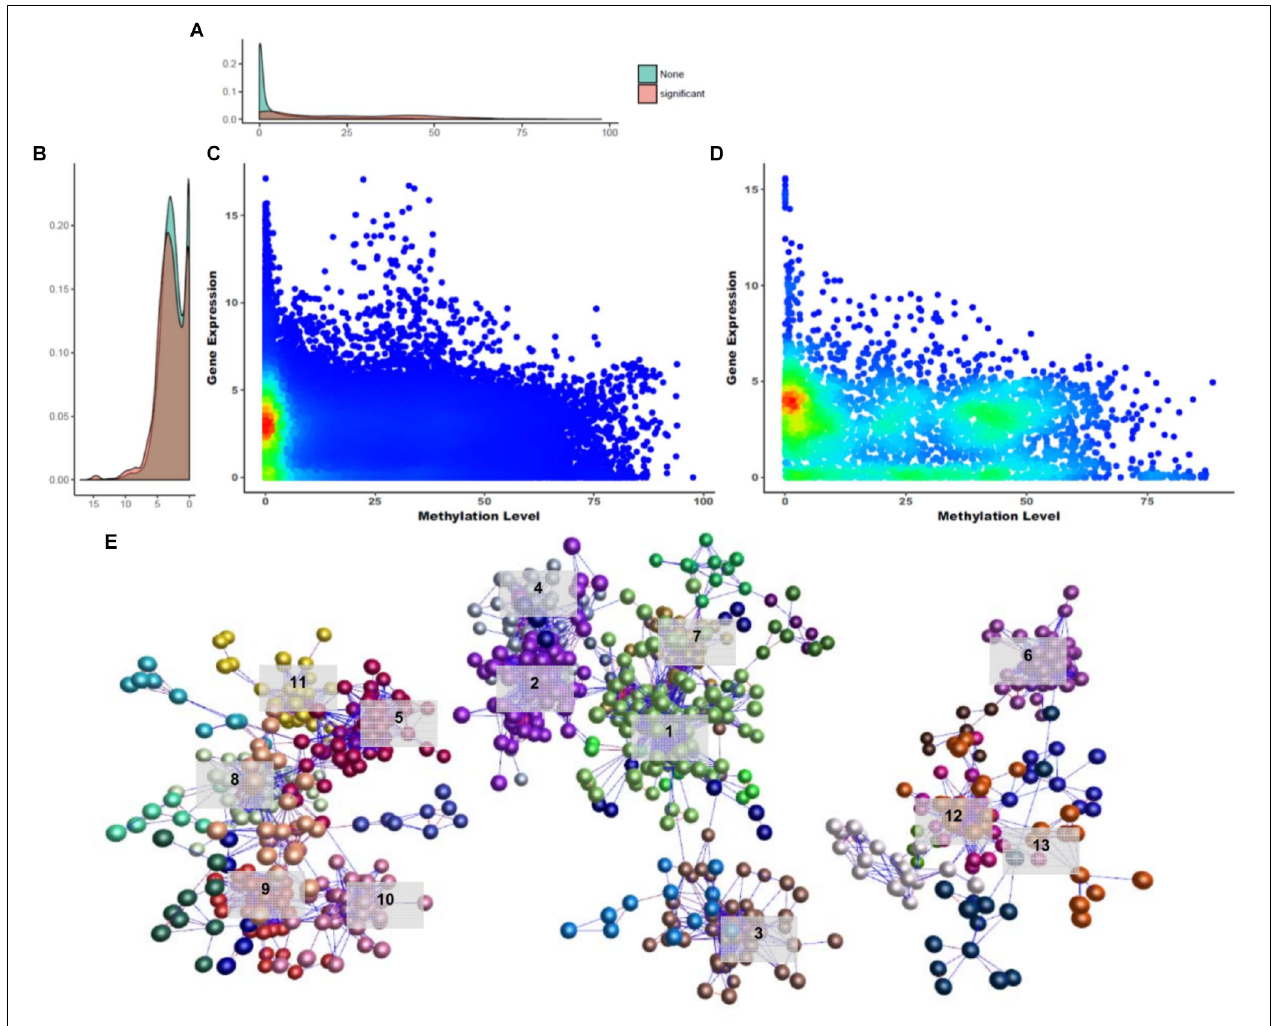
FIGURE 5 | Overview of gene silencing DNA methylations. (A) Gene expression density in Y -axis. (B) DNA methylation density in X -axis. (C,D) Density distribution of GSM candidates and GSMs. (E) Network constructed using GSM candidates (BioLayout Express 3D; r > 0.85; MCL = 1.3). It was divided into three subnetworks and 35 subgroups. The top 13 subgroups that had peaks in one tissue are marked. Highlighted edges (red) are significantly correlated genes with gene-silencing